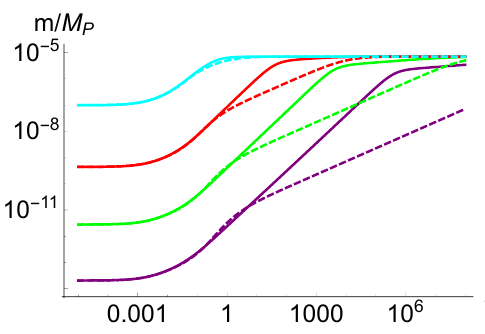
Figure 12. m vs. ξ for δ = 10 − 6 , 10 − 4 , 10 − 2 , 1 respectively in purple, green, red and cyan with N e = 50 e -folds in region 3. Continuous/dashed line represents metric/Palatini